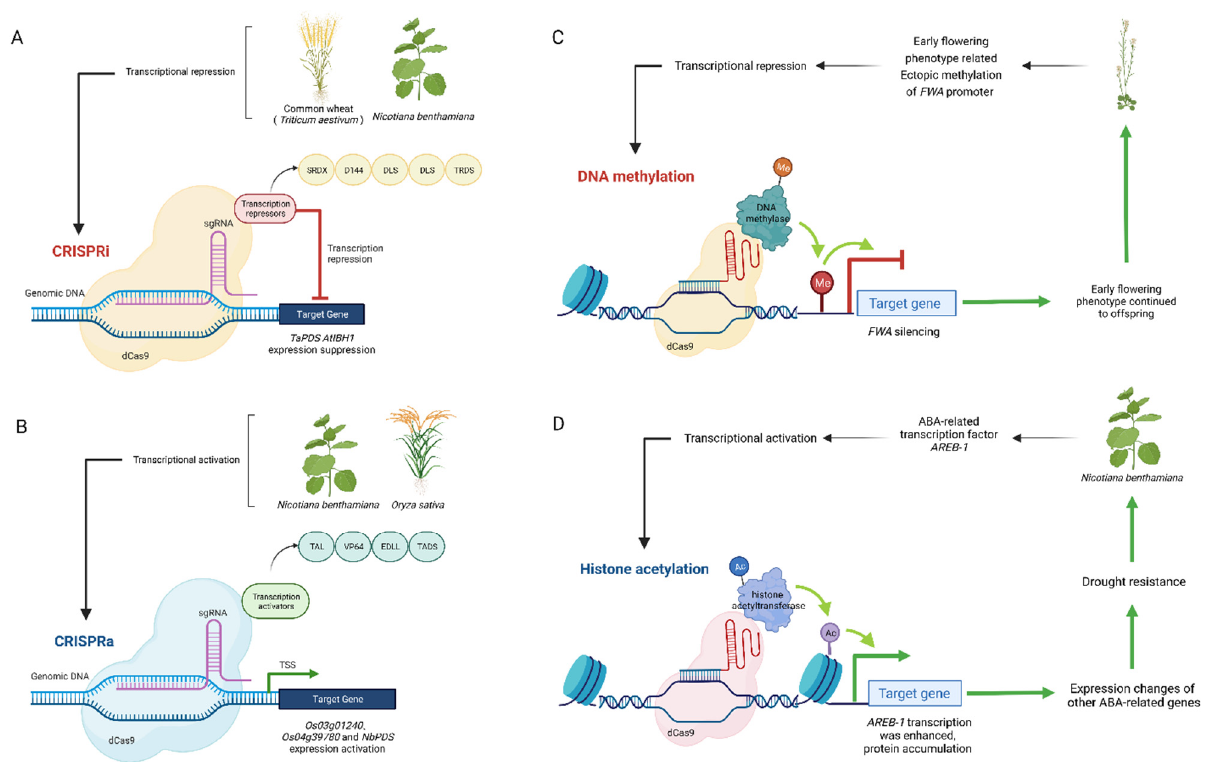
Figure 1. Application of CRISPR in plant epigenetic regulation (by Biorender). ( A ) CRISPRi inhibits the transcription of target DNA by forming a steric hindrance through the targeted binding of dCas9-sgRNA complex to target DNA. Piatek et al. fused the C-terminus of dCas9 to the transcriptional repressor domain of SRDX and successfully suppressed the transcription of endogenous genes in plant cells [32]. In addition, D144, DLS, and MIX were also successfully verified in monocotyledonous plant wheat to inhibit transcriptional activity [33]. ( B ) Activation of specific gene expression can be achieved by fusion of dCas9 with transcriptional regulators such as VP64 and EDLL. The expression of